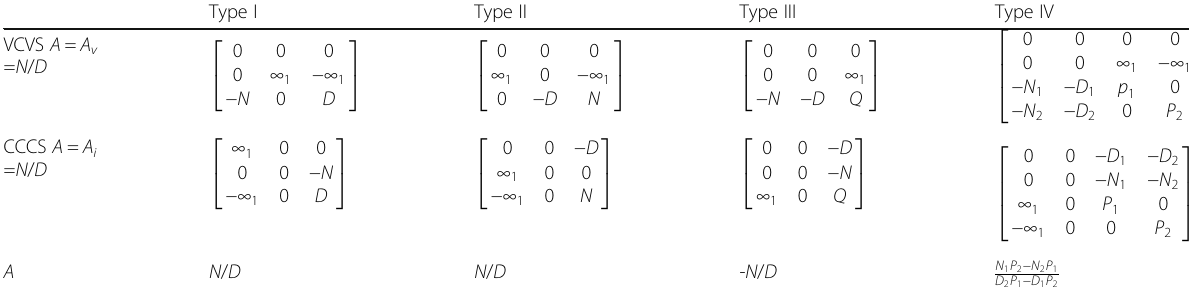
Table 1 Port admittance matrix descriptions of VCVS and CCCS [12] Type